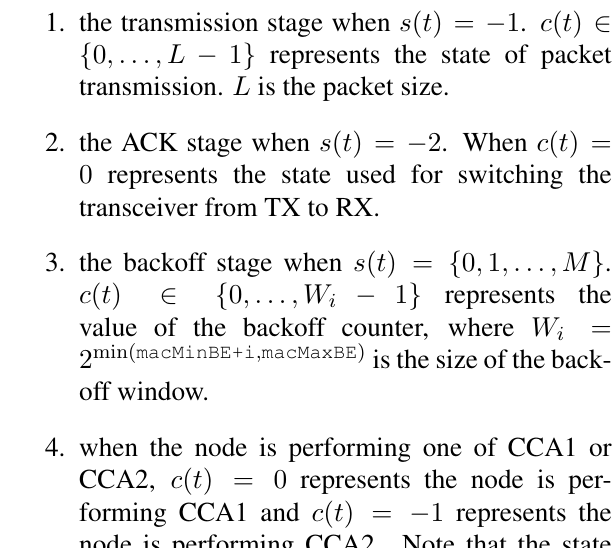
Fig. 3. Procedure of channel access with